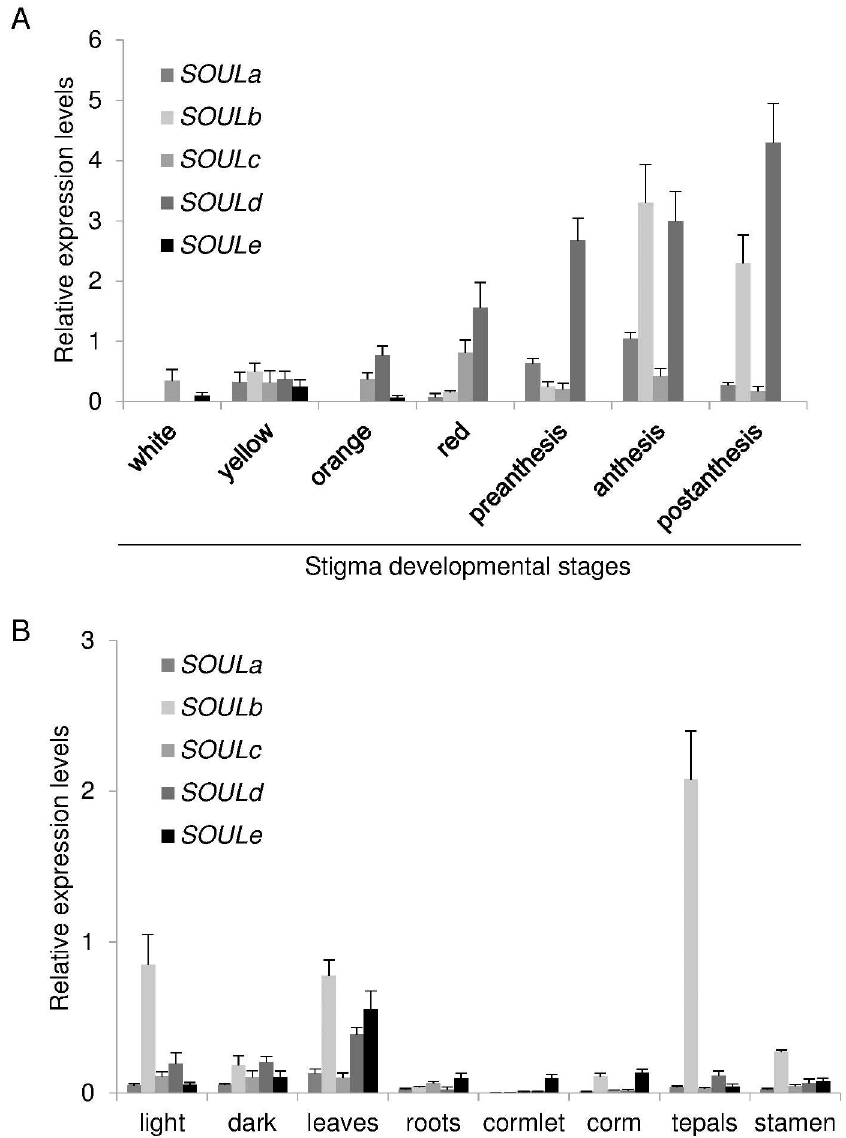
Fig 5. Expression analyses of SOUL genes in saffron stigmas and other tissues. (A) Relative expressionlevels of SOULa-e duringthe development of the stigma in saffron, developmental stages are the same as the ones represented in Fig 3A. (B) Relativeexpressionlevels of SOULa-e under two different light conditions and in severalsaffron tissues. Error bars depict